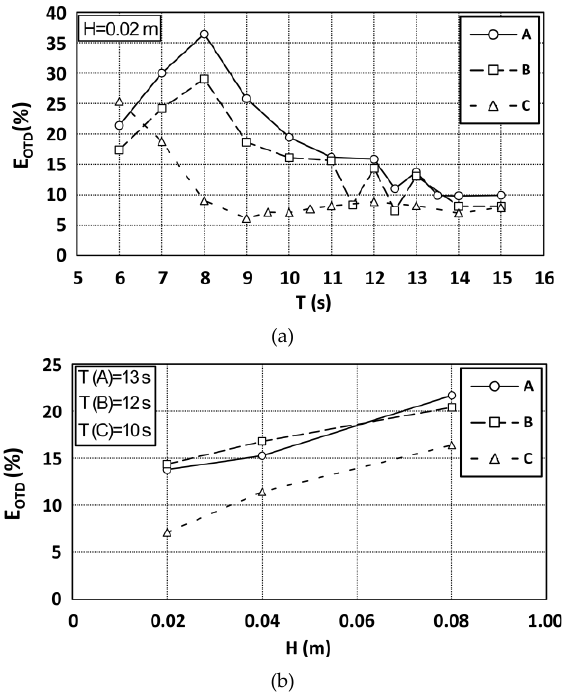
Fig. 8. Hydraulic efficiency of the OTD as a function of (a) wave period with a fixed wave height of 0.02 m and (b) as a function of the wave height for the resonant wave period of the OWC for each geometry.